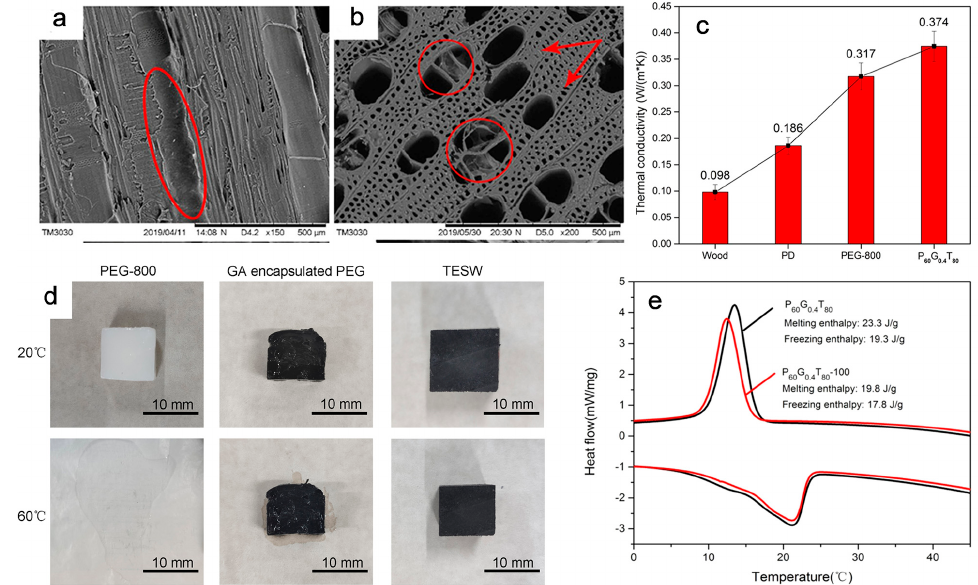
Figure 3. SEM images taken after impregnation of PEG/GA into the wood vessels; ( a ) radial section image ( b ) cross-section image, red circles and arrows in ( a , b ) show the successful filling of PEG/GA; ( c ) thermal conductivity performance comparison of wood, PD, PEG and TESW; ( d ) comparison of shape stability of samples and ( e ) cycles of thermal stability of TESW. Note: GA = graphene aerogel, PD = pure wood, PEG = polyethylene glycol, TESW = thermal energy storage wood. Adopted from reference [37], copyright 2020, IOP Publishing.